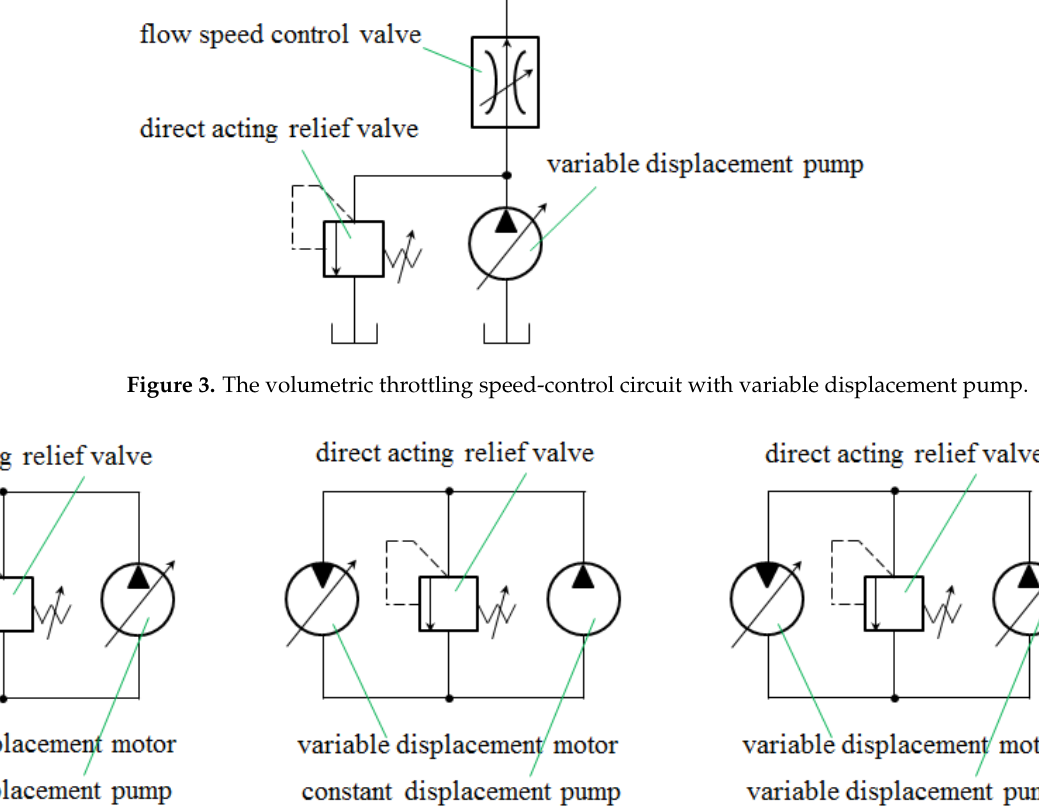
Figure 4. The volumetric speed-control circuit with variable/constant displacement pump/motor.